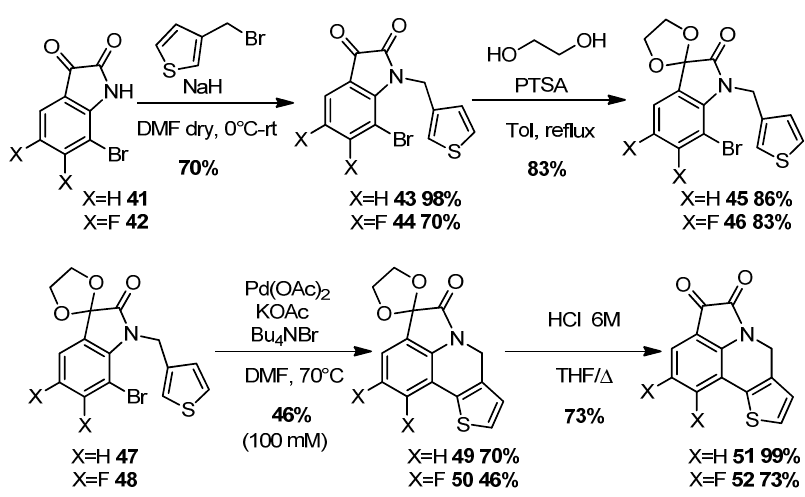
Scheme 8. Synthesis of isatin-based dyes with push-pull architecture. PTSA: p -toluenesulfonic